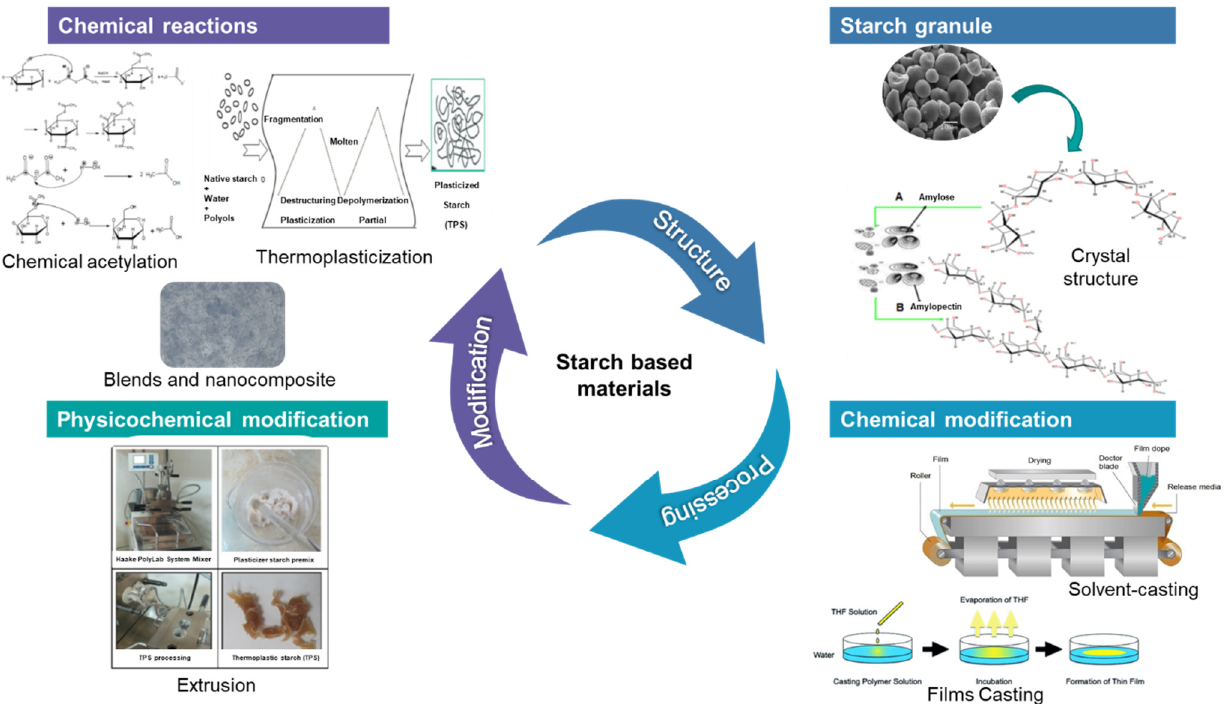
Figure 1. Schematic illustration of the structure, modifications and processing techniques of starch- based materials. The images were taken from various sources: Starch granule [13]; acetylation starch film [14]; plasticization starch [15]; solve casting and 3D printing [16]; and blend and nanocomposite starch [17].